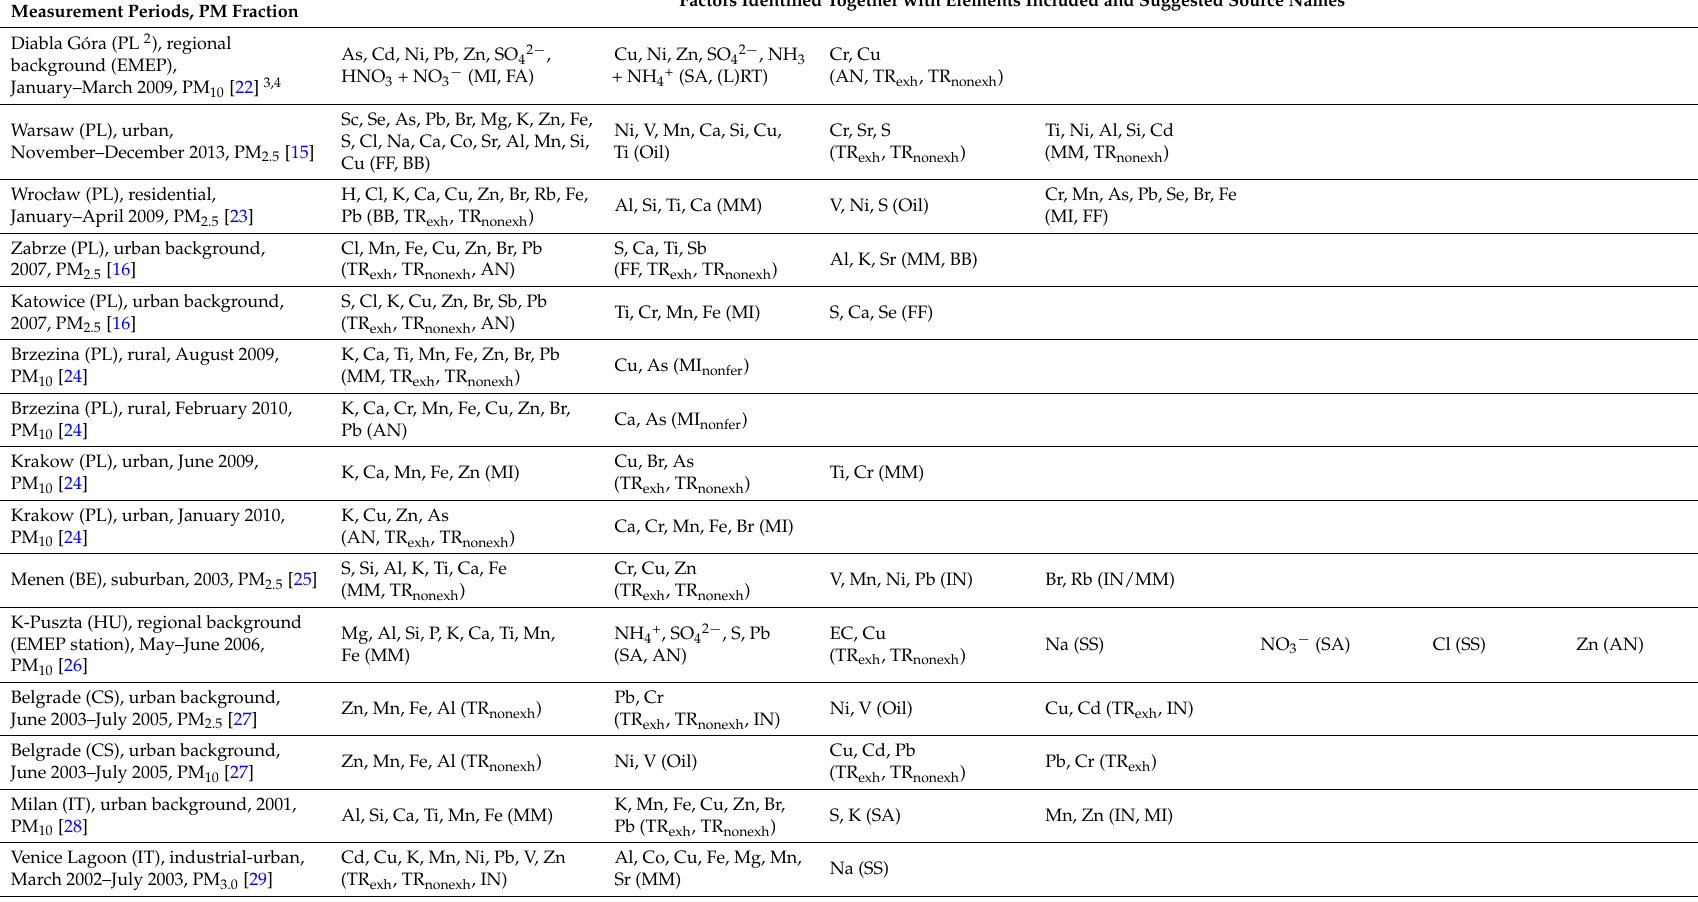
Table 1. Particulate matter (PM) source apportionment results based on the principal component analysis (PCA) and multi-linear regression analysis (MLRA) analysis obtained from research conducted at various locations all over the